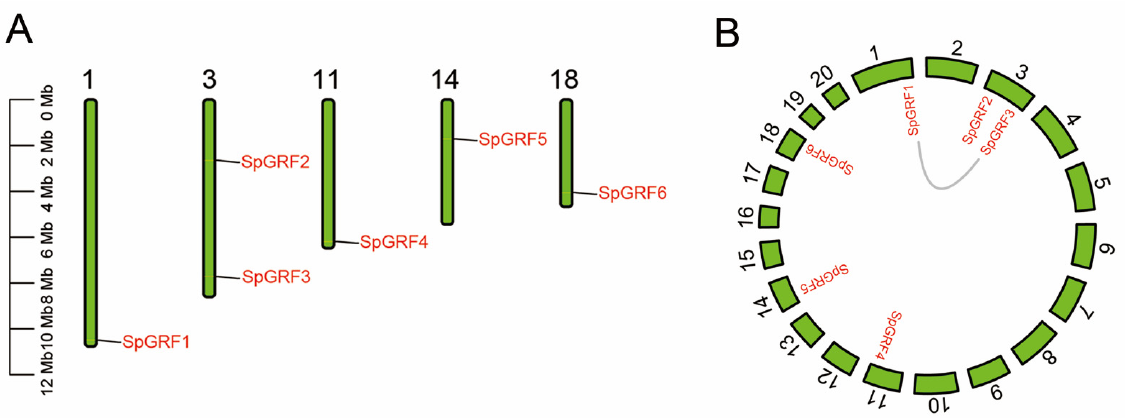
Figure 6. Chromosomal localization, gene collinearity, and synteny analysis of the SpGRFs . ( A ) Dis- tribution of the SpGRF genes on the chromosomes of S. polyrhiza . The scale bar indicates chromosome length (Mb). ( B ) Gene collinearity of the SpGRF genes on the chromosomes of S. polyrhiza .